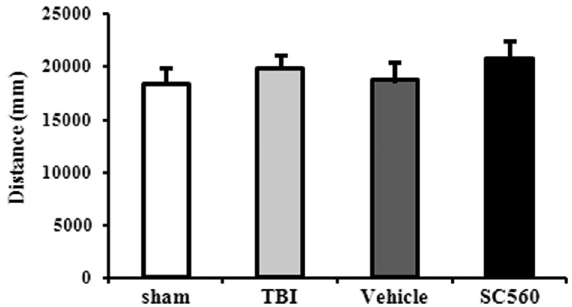
Figure 1. Effects of SC560 treatment in the traumatic brain injury (TBI) mouse model evaluated by the open field. Data are reported as means±SD (n=8). dpo: days post operation. Neither TBI nor SC560 treatment altered the gross motor ability detected by the open-field